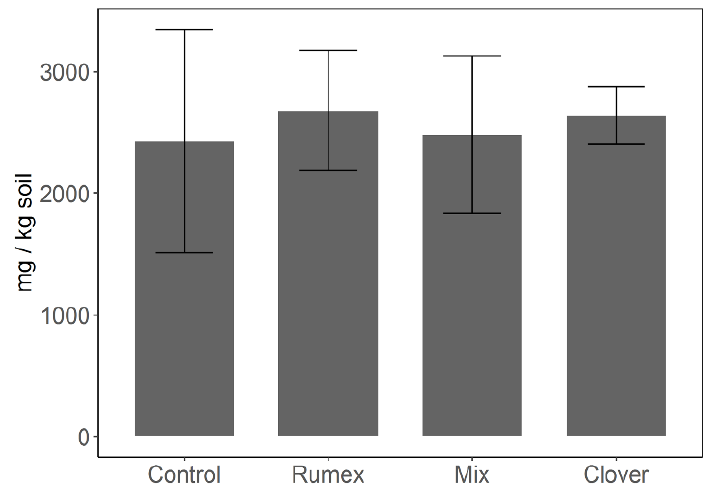
Fig. 6 Microbial biomass control, Rumex , mix, and clover treat- ments at 28 days of incubation Level of significance was determined using one-way ANOVA. There were no significant bars represent standard deviations of mean val- ues (n =